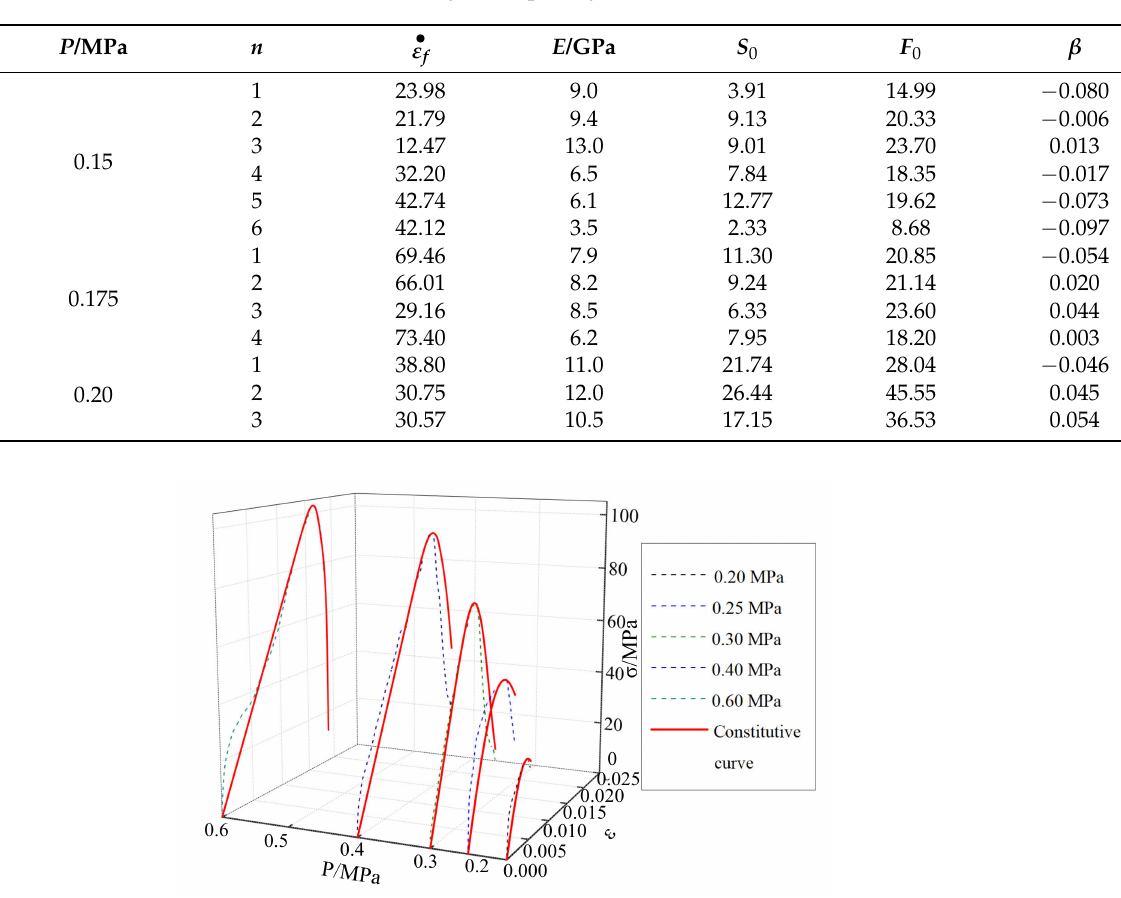
Table 4. Parameters of the cyclic-impact dynamic constitutive model of mudstone.